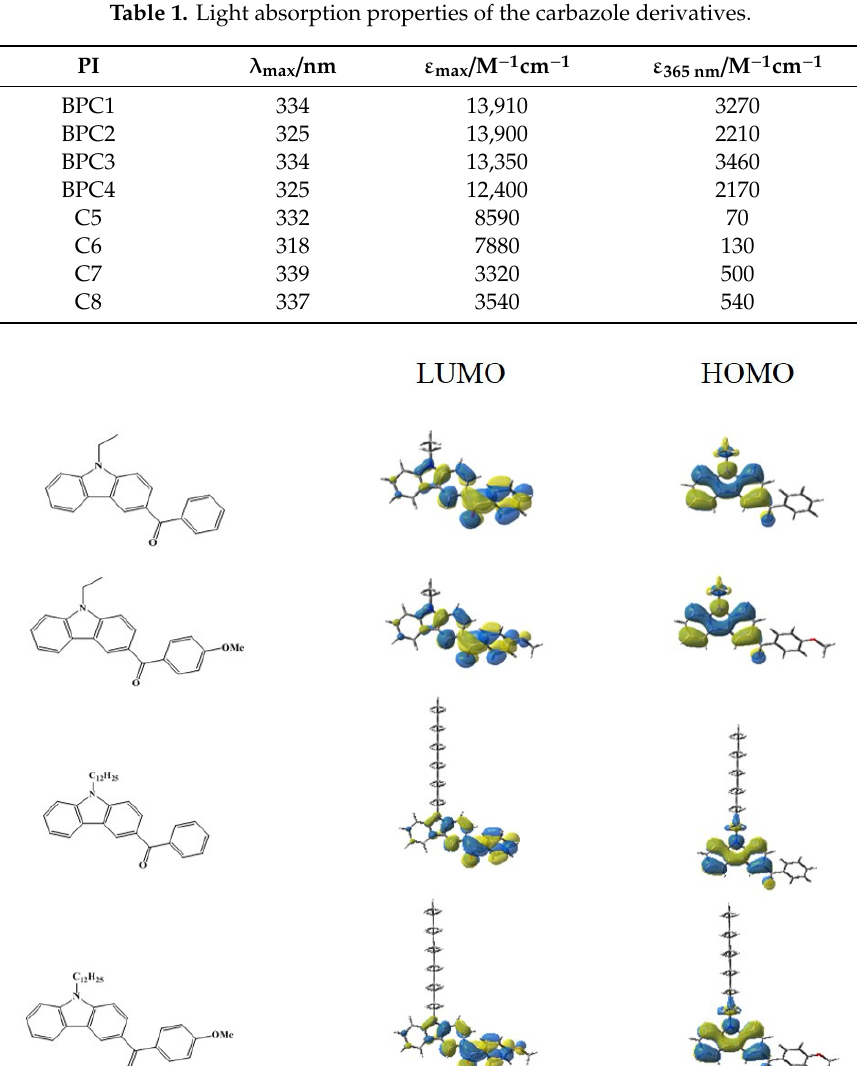
Figure 2. Highest occupied molecular orbital (HOMO) and lowest unoccupied molecular orbital (LUMO) of BPC1-BPC4 calculated at the B3LYP/6-31G* level of theory. Table 1. Light absorption properties of the carbazole derivatives.